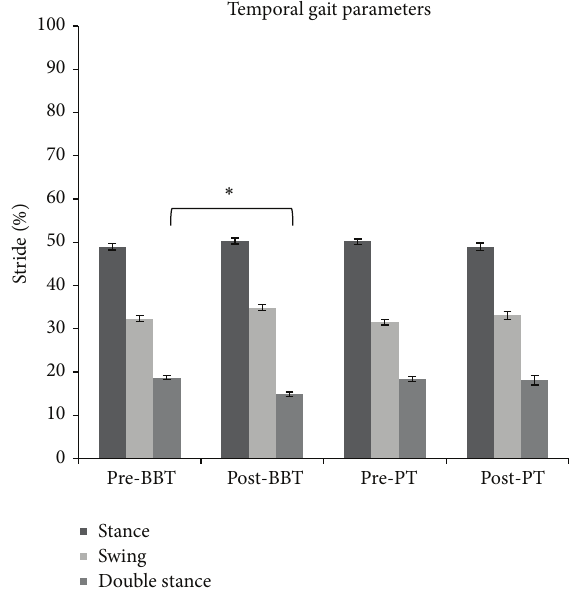
Figure 4: The graph shows the effects of BBT and PT on percentage of stance, swing, and double stance phases (dark grey, light grey, and grey, resp.) with respect to entire stride phase. Error bars indicate the standard error. ∗ 𝑝 < 0.05 . PT: physical therapy; BBT: blindfolded balance